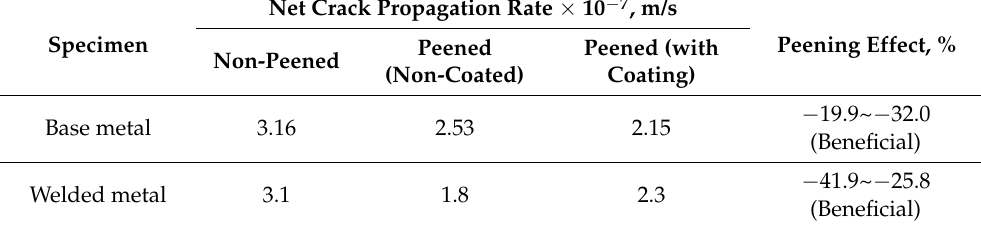
Table 7. Laser shock peening effect on SCC propagation rate of 304L stainless steel in boiling 42% MgCl 2